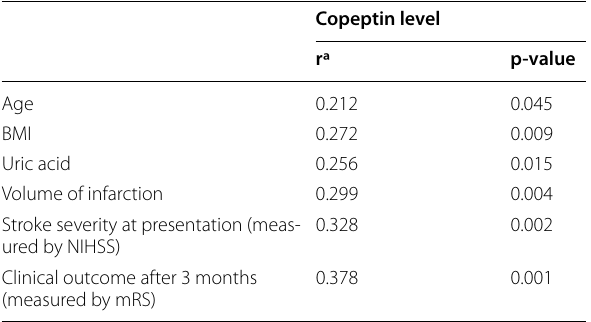
As demonstrated in Fig. 1, receiver operating char- acteristic (ROC) curve analysis was used to assess the prognostic role of copeptin level after acute ischemic stroke. With sensitivity of 62.2% and specificity of 84.4%, the optimal cutoff value of copeptin that pre- dicted unfavorable stroke outcome was 125.30 pg/ml ≥